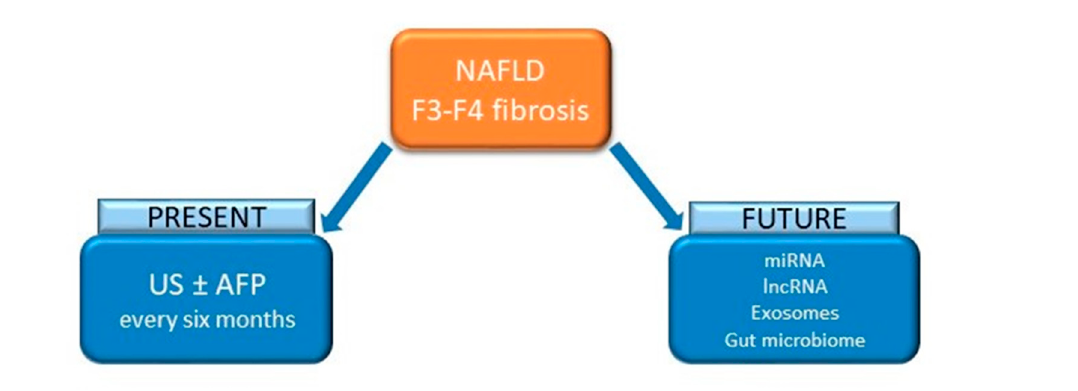
Figure 2. HCC surveillance in patients with NAFLD and advanced fibrosis: Present and future